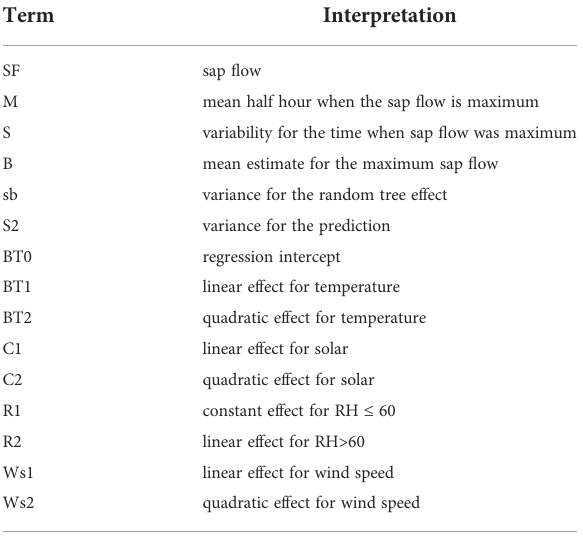
TABLE 2 Abbreviations for terms used in equations 1 and